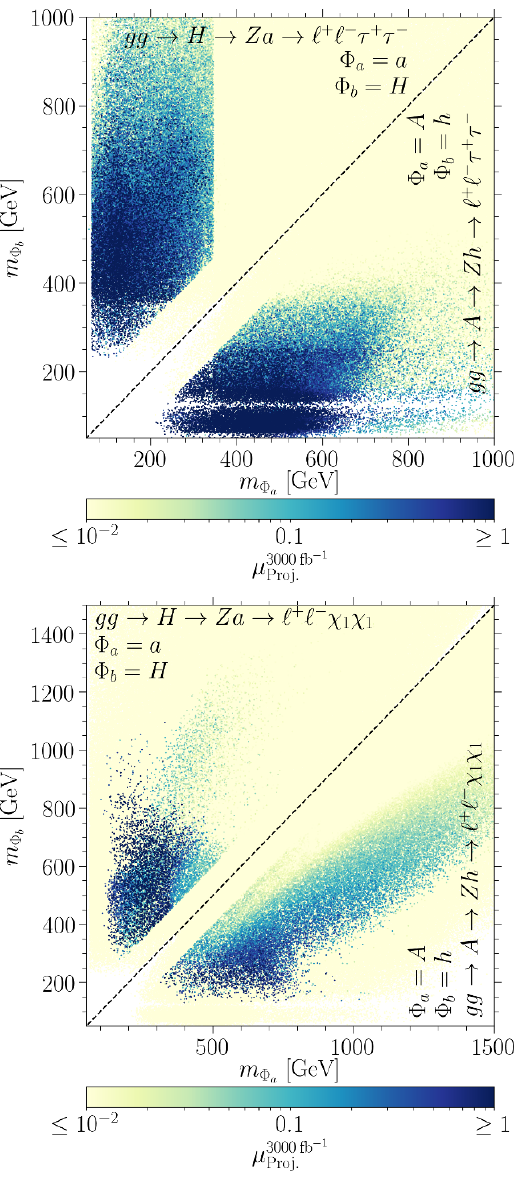
Figure 6 . Signal strength (cid:22) 3000fb (cid:0) 1 (cid:17) (cid:27)=(cid:27) 3000fb (cid:0) 1 as indicated by the color bar, where (cid:27) is the Proj : Proj : cross section of the parameter point and (cid:27) 3000fb (cid:0) 1 the estimated sensitivity for L = 3000 fb (cid:0) 1 of Proj : data in the respective channel. The top panels are for Z +visible (left) and Higgs+visible (right). The bottom panels show the sensitivity in the mono-Higgs (left) and mono- Z (cid:12)nal states (right). In each panel, the two triangles separated by the dashed line correspond to a parent CP-even state H (upper left triangle) or a parent CP-odd state A (lower right triangle). For the left panels, the x -axis corresponds to m a ( m A ) and the y -axis to m H ( m h ) for the upper left (lower right) triangle. For the right panels, the x -axis corresponds to m h ( m A ) and the y -axis to m H ( m a ). The hard cuto(cid:11) at masses of the parent state below (cid:24) 350 GeV in the top right panel (Higgs+visible) is due to the mass ranges for which the sensitivity in these (cid:12)nals states is available in ref. [22]. Note also that in the bottom left panel the mass range extends up to 1 : 5 TeV, while in the other panels we show only the mass range up to 1 TeV.